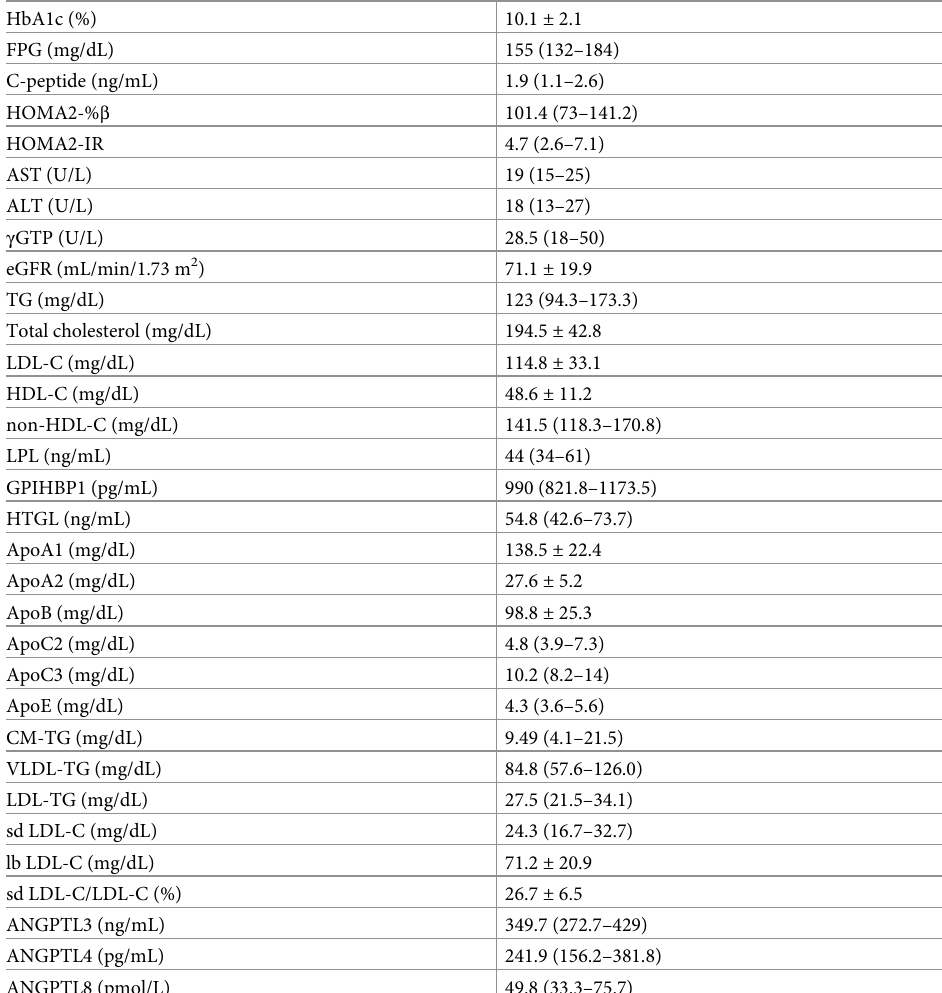
Table 2. Clinical characteristics and laboratory